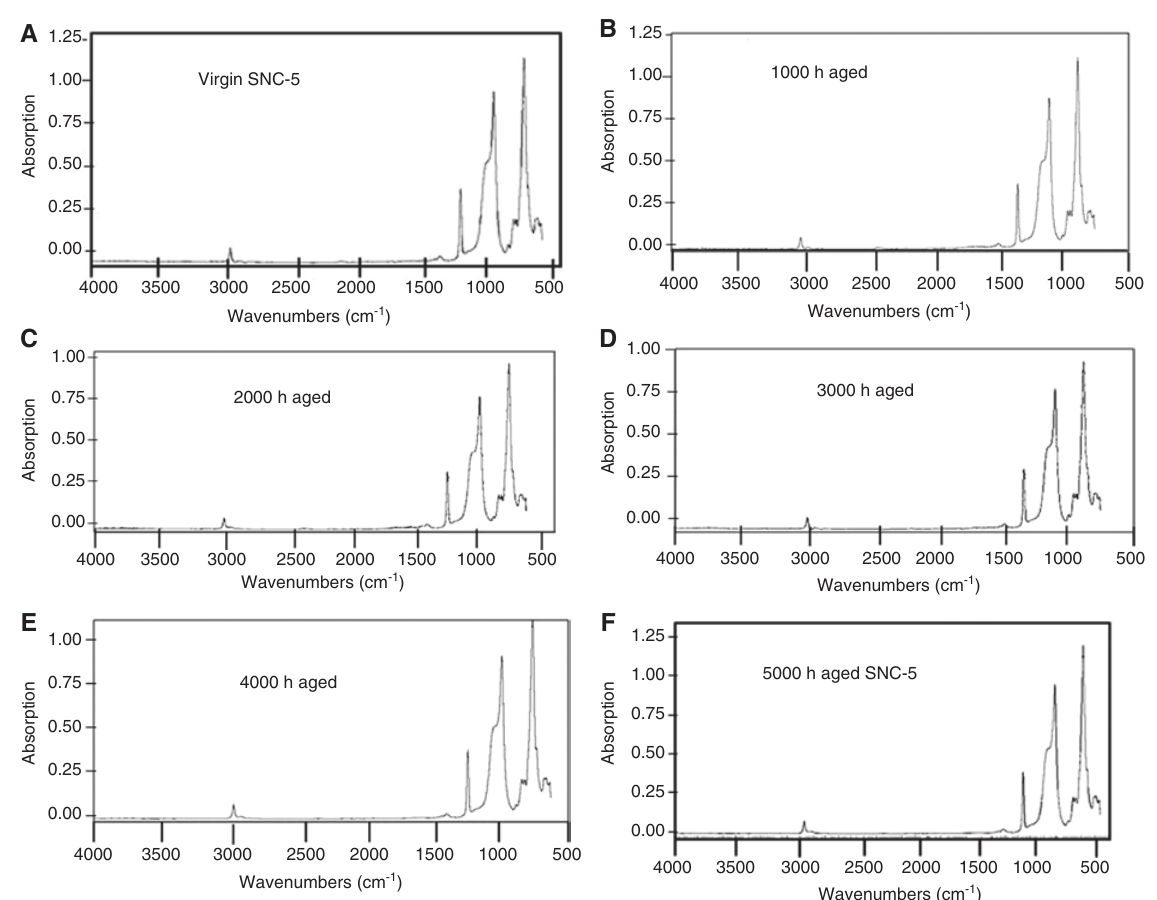
Figure 10: FTIR spectrographs: of SNC-5: (A) virgin, (B) 1000 h aged, (C) 2000 h aged, (D) 3000 h aged, (E) 4000 h aged, and (F) 5000 h